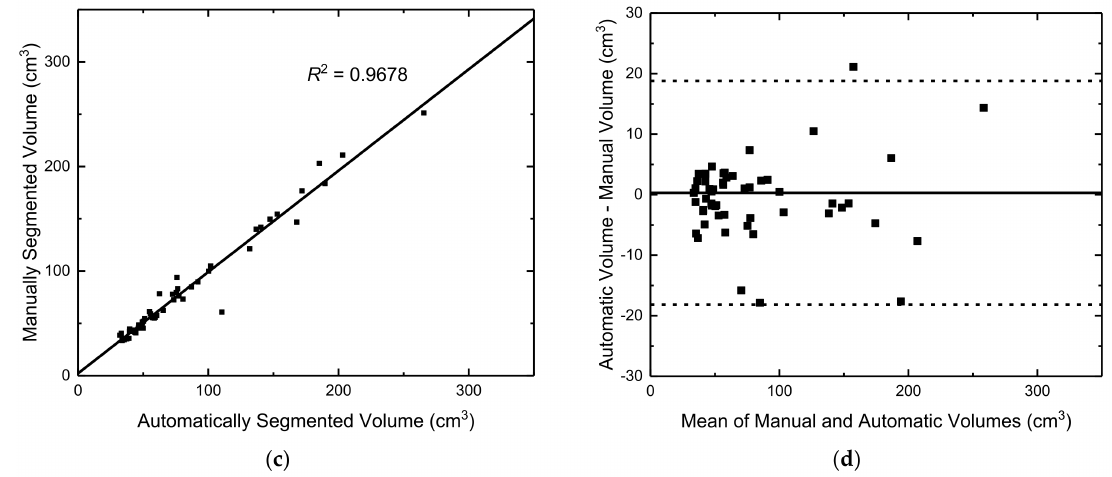
Figure 5. Correlation between manual and automated ( P AVG ) foetal brain volume measurements for ( a ) 200 normal cases and ( c ) 54 abnormal cases. Bland–Altman plots showing the limits of agreement between automatic and manual foetal brain volumes for ( b ) the 200 normal cases and ( d ) the 54 abnormal cases.